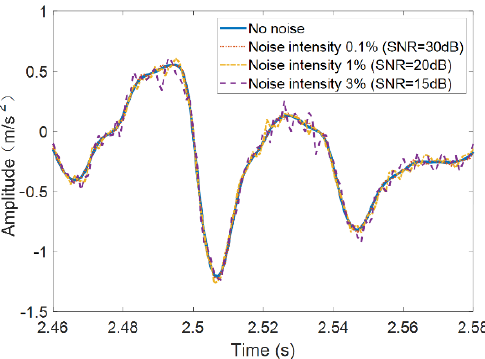
Figure 11. Wheel acceleration in healthy state under different noise levels.